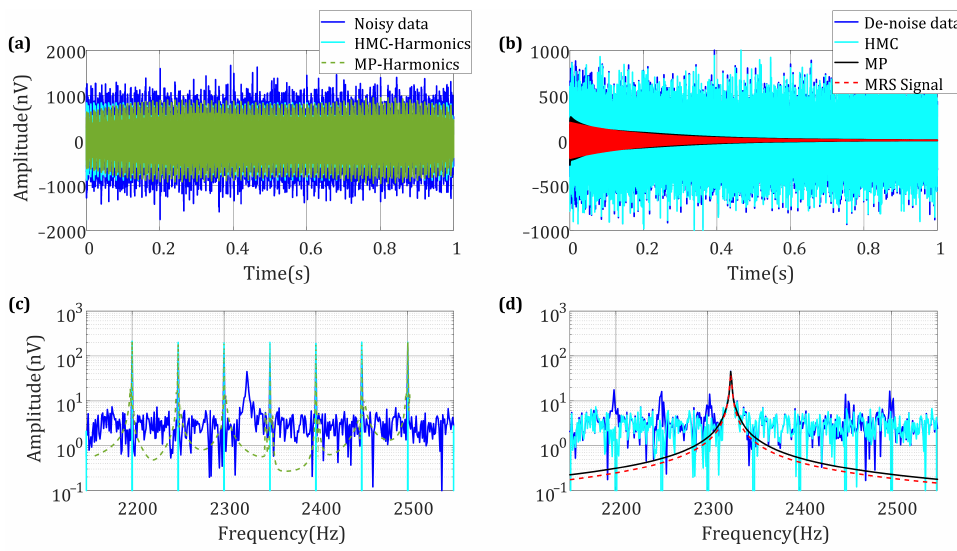
Figure 2. Denoising results of the MP algorithm when SNR = − 20.05 dB: ( a ) noisy data and recon- structed power-line harmonics by MP and HMC; ( c ) is the corresponding spectrum. ( b ) After removing the harmonics, the MRS signal is extracted by MP and HMC; ( d ) is the corresponding